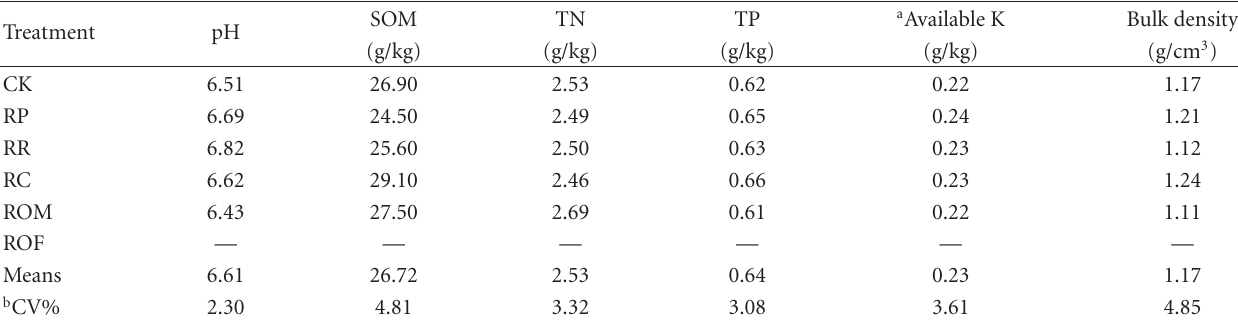
Table 2: General soil properties before the experiment started in 2001 (0–20 cm soil depth).